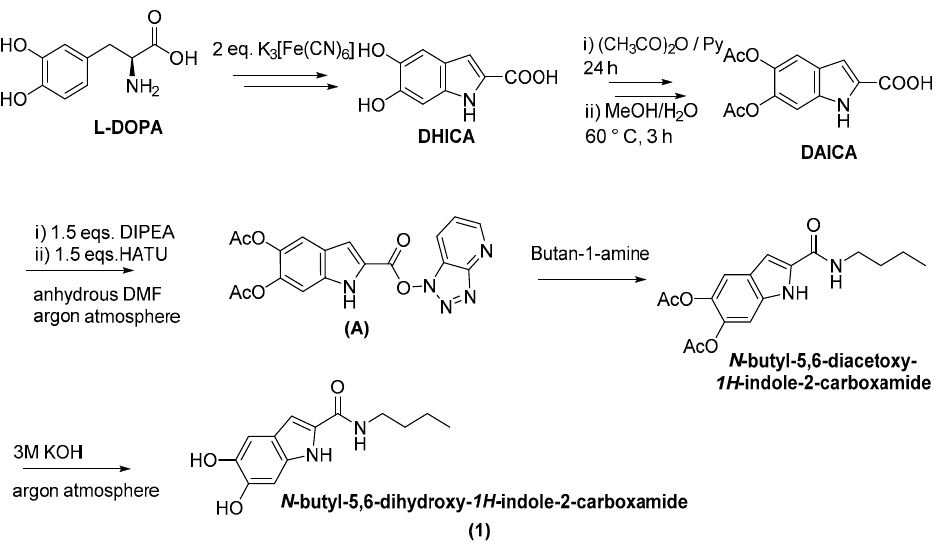
Figure 1. Synthesis procedure for DHICA amides. Shown is also preparation of DHICA from